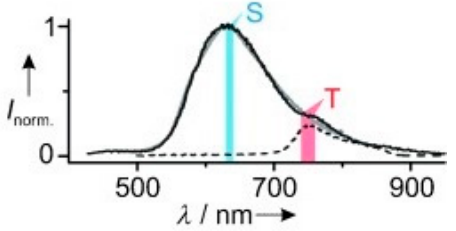
Figure 14. Electrically and optically excited phosphorescence from high-lying triplets of 58 . EL spec- trum at 4 K (red), room-temperature solution PL (gray) and gated dilute-film PL (25 K, dashed). Two dominant distinct phosphorescence peaks are identified. Adapted with permission from [61]. He et al. [62] proposed a design strategy to develop pure-phosphorescent single-mol- ecule white light emitters by incorporating benzophenone derivatives into the dibenzothi- ophene unit. By Friedel–Crafts acylation, five compounds, namely dibenzo[ b , d ]thiophen- 2-yl(phenyl)methanone